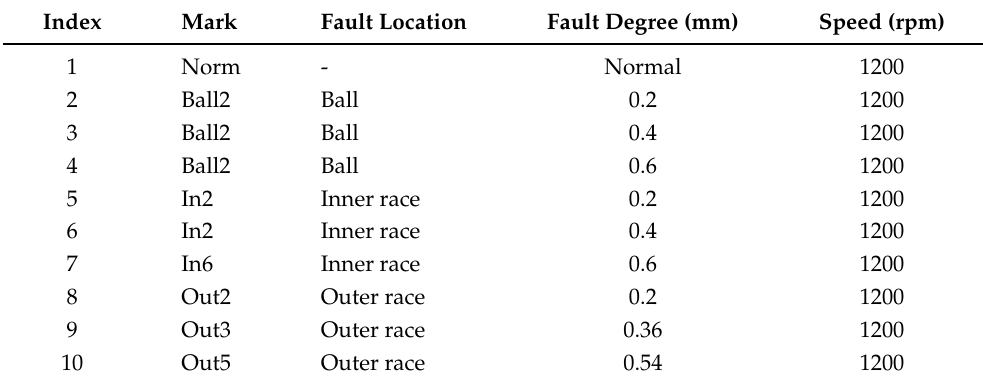
Table 5. Specifications of DUT dataset.